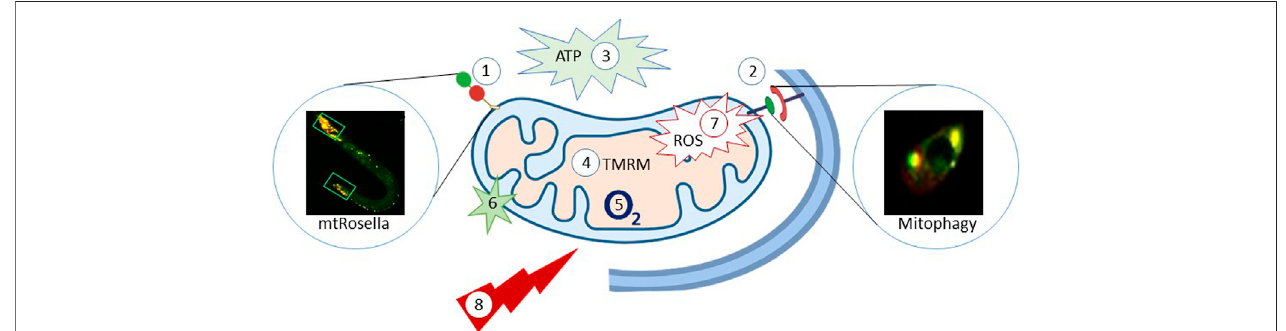
FIGURE2| C.elegans asmodelorganismtostudymitochondrialhomeostasisandfunction.The C.elegans provideawaytomonitormitophagy;1:Mitochondria- target Rosella (mtRosella), using the Rosella biosensor combining a pH-insensitive DsRed and pH-insensitive GFP. 2: Co-localization between DCT-1 (outer mitochondrial membrane protein) and LGG-1 (autophagosomal membrane protein, homolog of the mammalian LC3). 3: Luciferase-based methods to evaluate how different conditions affectsthe production ofATP in C. elegans; The Roche ATPbioluminescent assay kit HSII isanother way to determine ATPcontent.4: TMRM: the TMRM staining-tetramethylrhodamine, ethyl ester, perchlorate, a dye that accumulates in intact, respiring mitochondria. 5: Oxygen consumption rate (OCR) is another parameter to re fl ect mitochondria function. 6: Mito Tracker Green FM is a green- fl uorescent dye that stains mitochondria in live cells and its accumulation is dependent on membrane potential. 7: mitochondrial ROS and cellular ROS can be quanti fi cation via mtROS (MitoTracker Red CM-H2X ROS); DHE (dihydroethidium), respectively. 8: Stress resistance-survival can also be detected via a heat stress assay, CCCP stress assay, ultraviolet light stress assay, paraquat-induced oxidative stress assay and starvation assays. The fi gure has been generated using power point image building tool by the author.